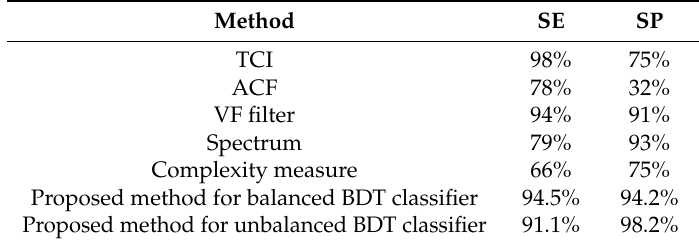
Table 10. Comparison of five popular VF detection algorithms to the proposed method.